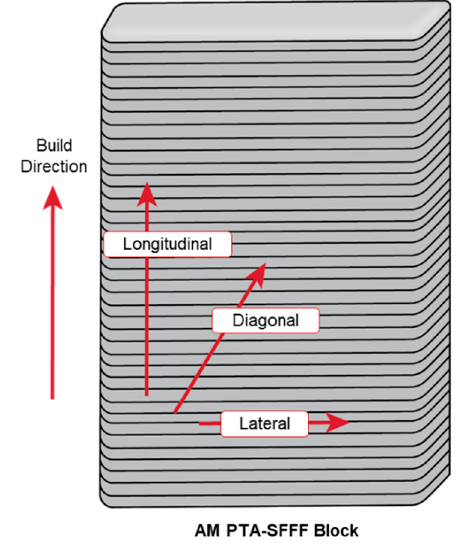
Figure 1. PTA ‐ SFFF Ti–TiB AM block highlighting sample directions considered for tensile testing. Produced AM blocks were approximately 22 cm by 10 cm by 5 cm in size.